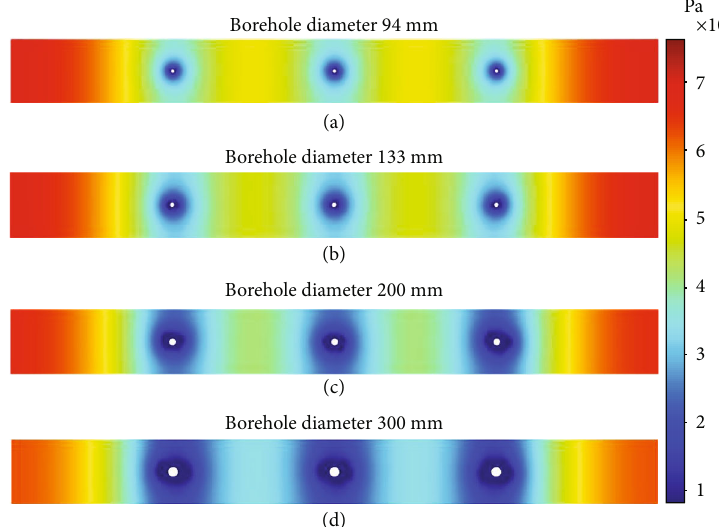
Figure 9: Gas pressure of coal seam after di ff erent diameters in soft coal seam (120 days).